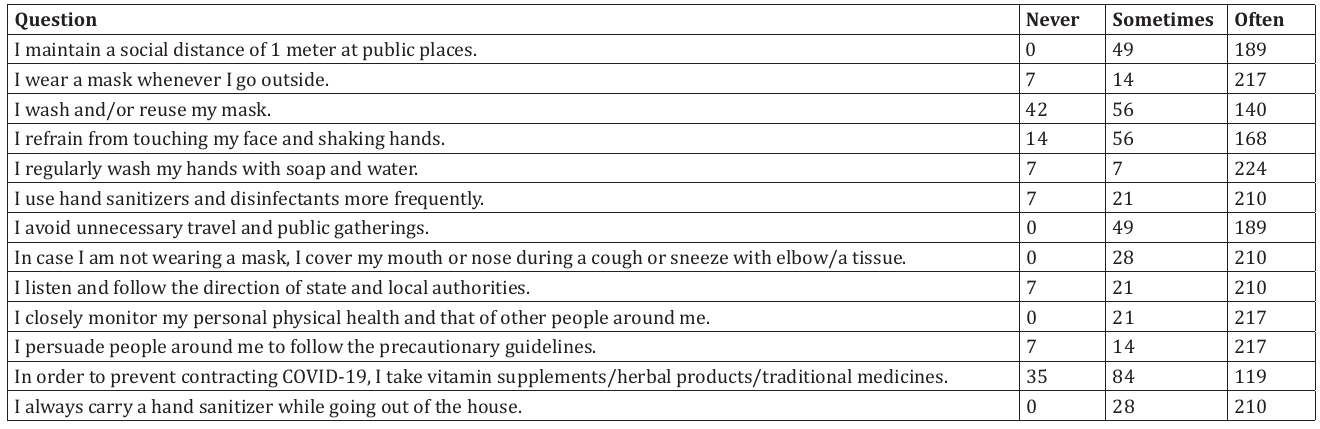
Table 5 Response to Practice aspect for Covid-19 infection with once choice